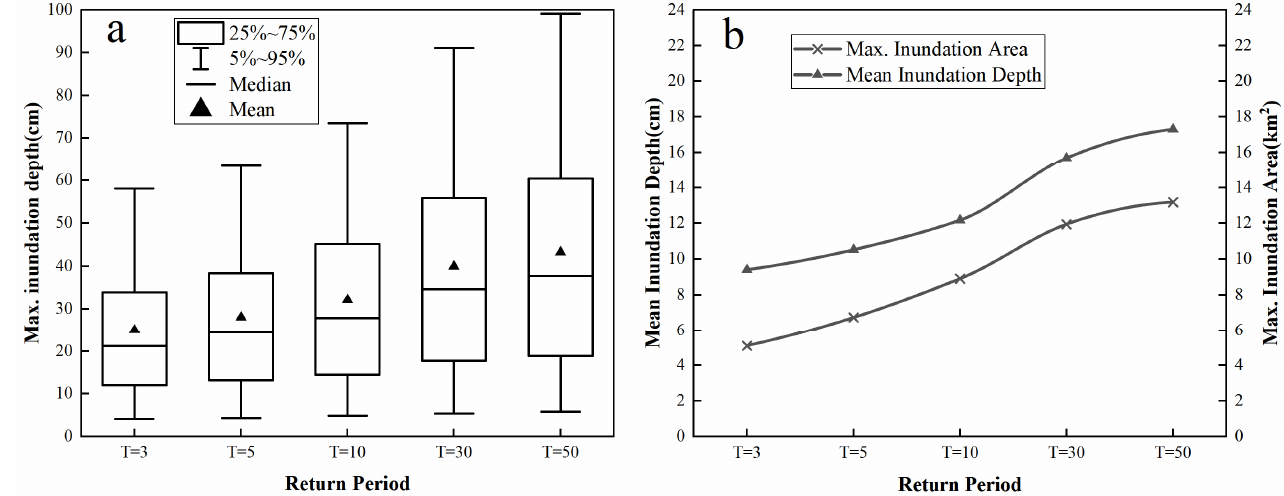
Figure 7. ( a ) Boxplots of the maximum inundation depth distribution under different return periods; ( b ) mean inundation depth and maximum inundation area under different return periods.